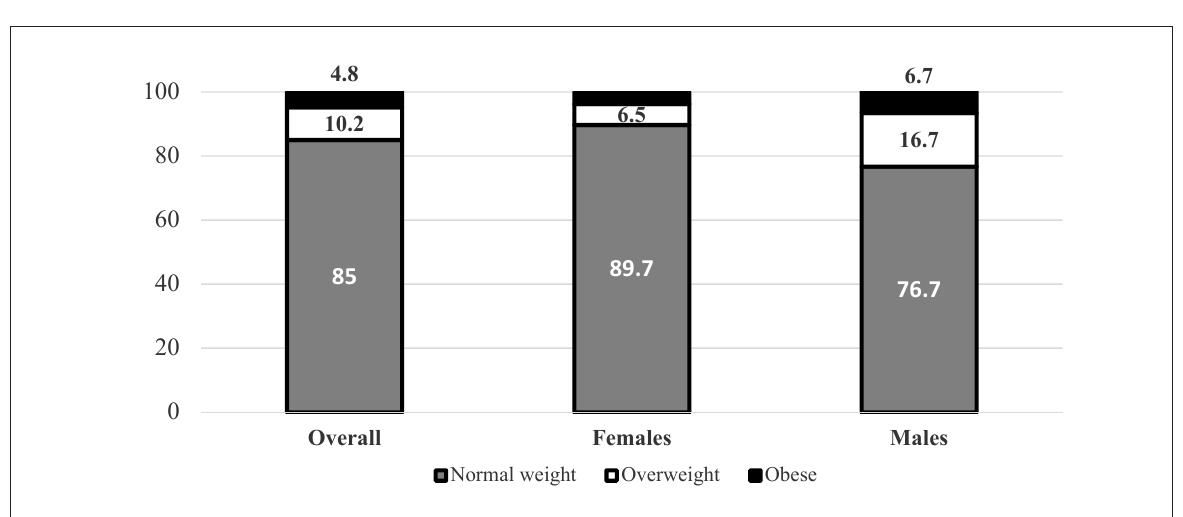
Figure 2. Bodyweight distribution by the gender Figure 2 . Bodyweight distribution by the gender p = .043). Students who had diagnosed dyslexia 89.8% ( n = 8) were inadequately health literate. NVS, EHIL1-9 and EHIL8 results were compared with each other. We found no differences between HL and HIL levels ( p = .731). NVS results were positively correlated with EHIL8 statement “Terms and sentences of health information are often difficult to understand” ( r = .662, p = .034).